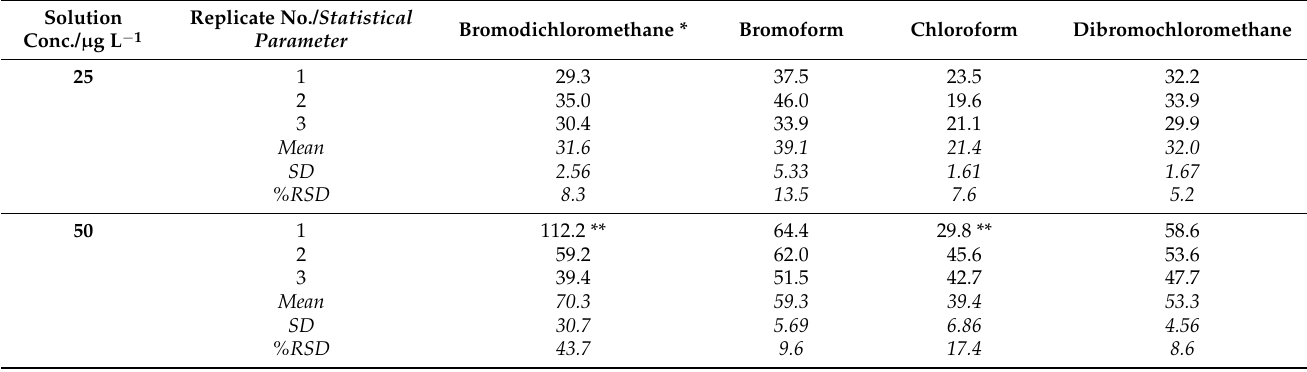
Table 10. Accuracy data ( µ g L − 1 in solution) for each of the triplicate measurements of 25, 50, and 75 µ g L − 1 THM spikes in drinking water (Cambridge, UK). The mean, standard deviation (SD), and RSD (in %) are also shown. Concentration measurements are averaged across quantitation